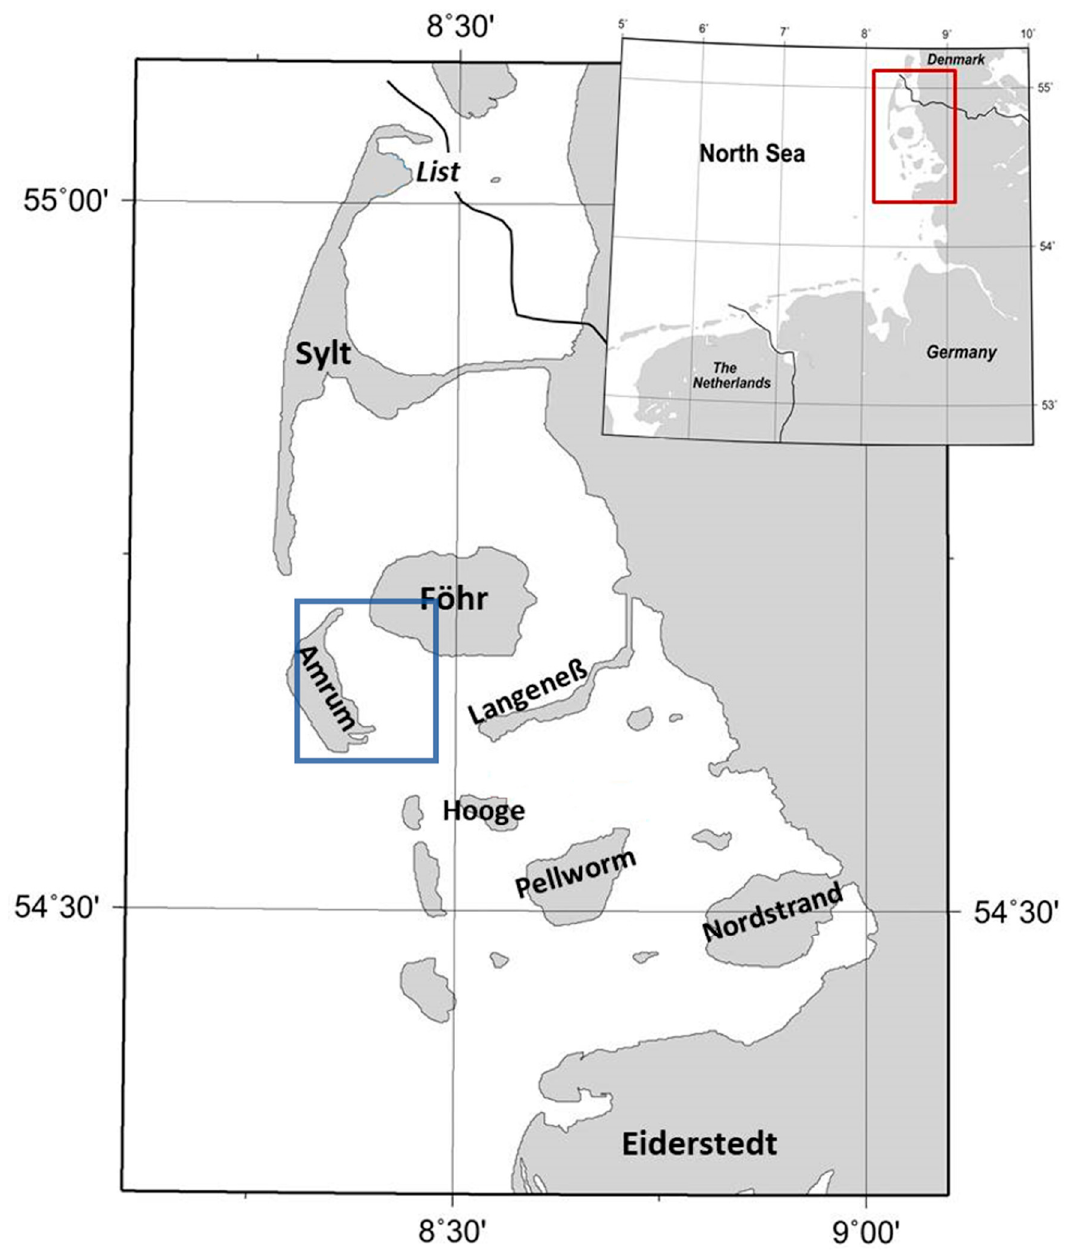
Figure 1. Area of interest (blue rectangle in the large map) on the German North Sea coast, east of the island of Amrum, and southwest of the island of Föhr.